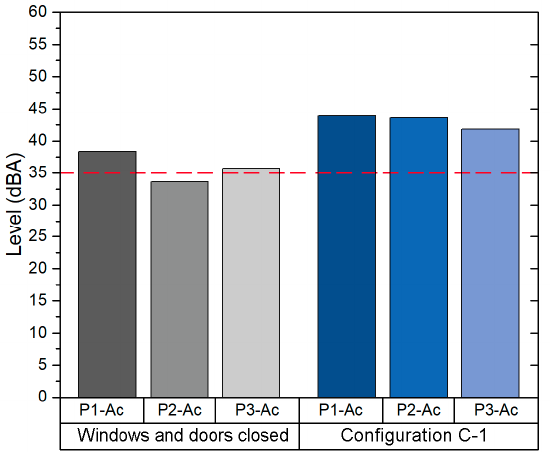
Figure 8. Background noise levels in classroom B1-A2.